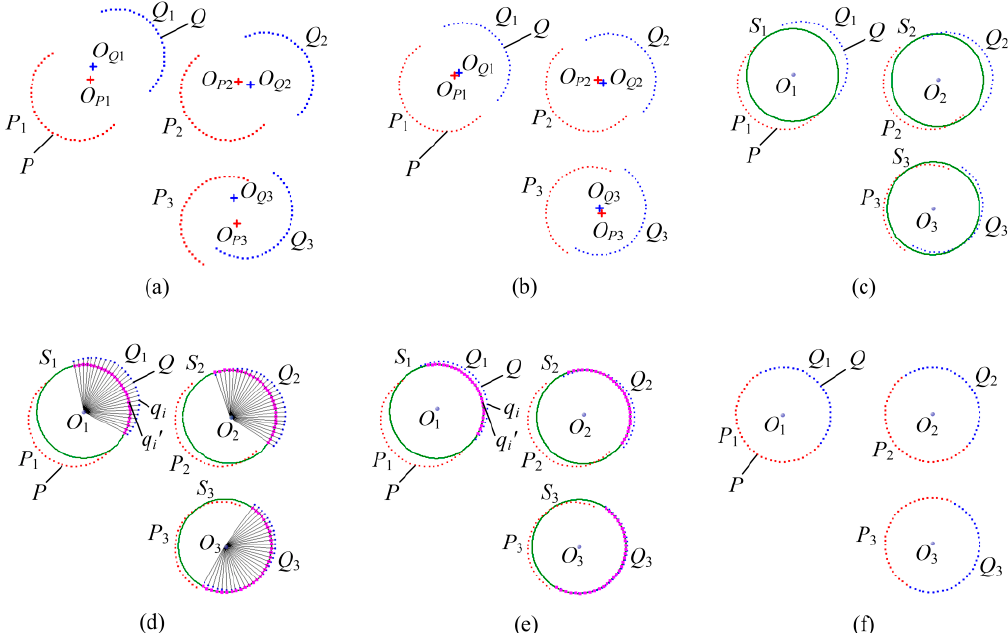
Figure 3. Two-dimensional schematic of the registration procedure of FCR: ( a ) identification of two point clouds to be registered; ( b ) rough registration by fitted sphere centers; ( c ) feature sphere fitting; ( d ) calculation of corresponding points; ( e ) solution of the rotation and translation matrices and ( f ) result of the registration.